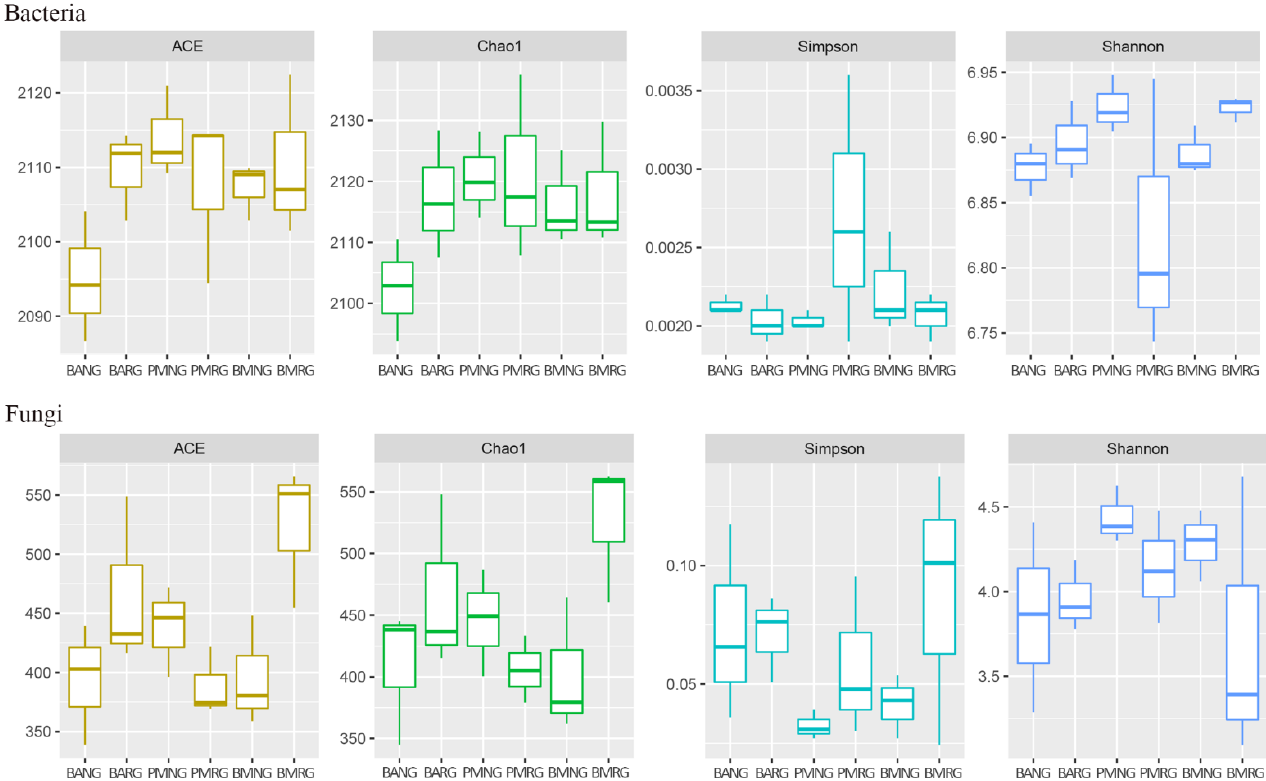
Figure 2. The α -diversity of bacteria and fungi in garlic field under different treatments.